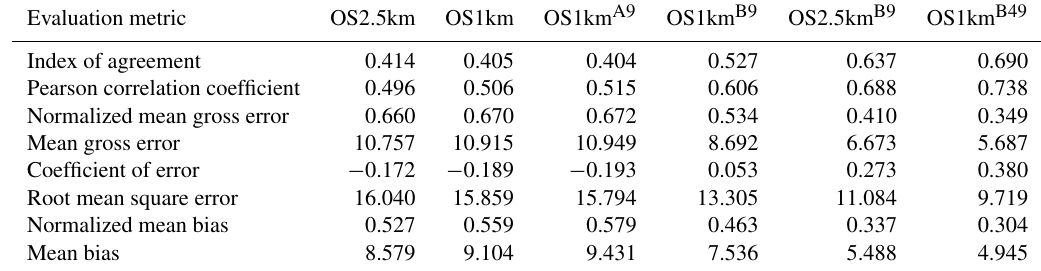
Table 4. Surface O 3 observations to model comparison for entire simulation period (ppbv, 2189 model–observation pairs). Evaluation metric